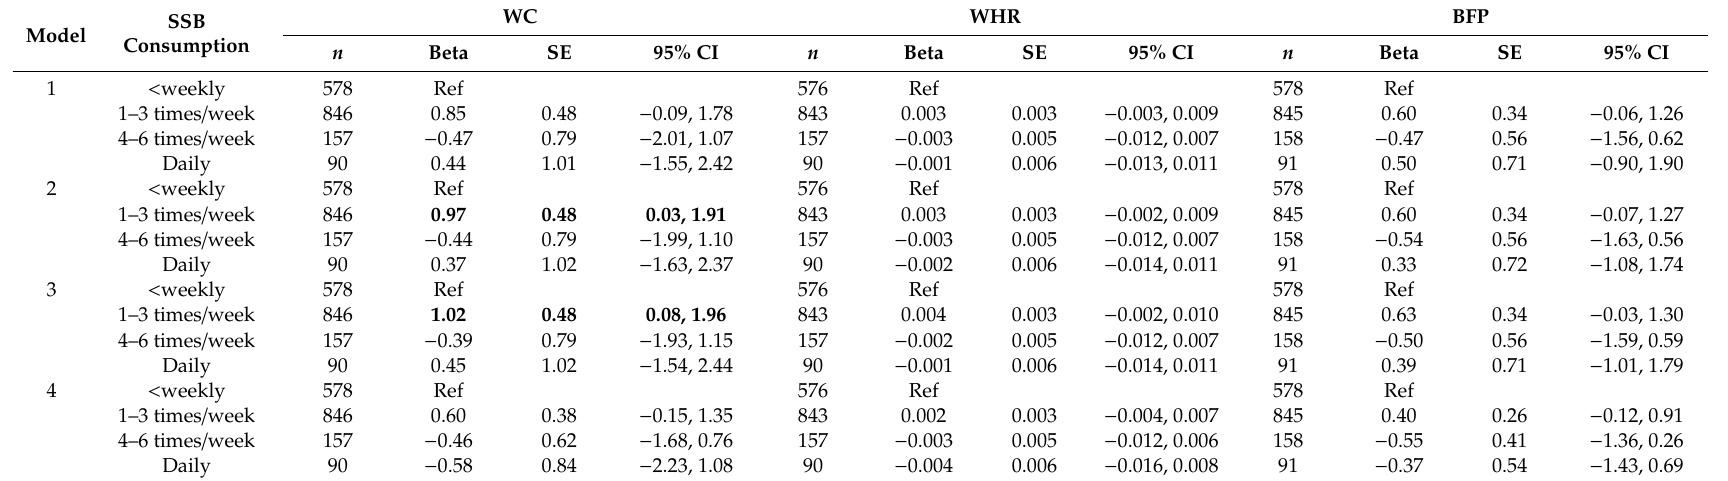
Table 3. Associations of sugar-sweetened beverage (SSB) consumption at 11 years with waist circumference (WC), waist-to-hip ratio (WHR) and body fat percentage (BFP) at 16–19 years in Hong Kong’s “Children of 1997” birth